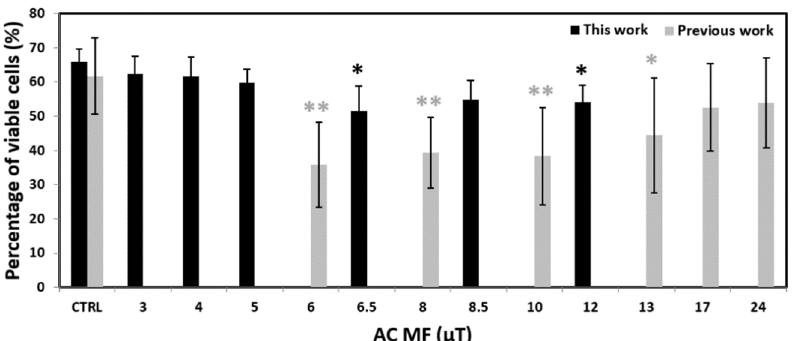
Figure 2. Percentage of viable cells after a 72 h exposure of UCBLs to the waveform 7.8tAM: our results from a previous work [27] combined with those of the present work. Experiments were done six times in our previous work (N = 6) while in triplicate in this work (N = 3). All MF values are peak values. * p < 0.05, ** p < 0.01. Bars denote standard deviation